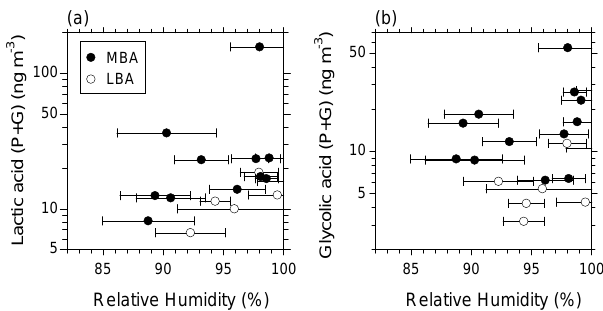
Figure 4. Concentrations of (a) lactic and (b) glycolic acids in the gas and particle ( g + p ) phases as a function of relative humidity for MBAs and LBAs. The y axis is plotted on a log